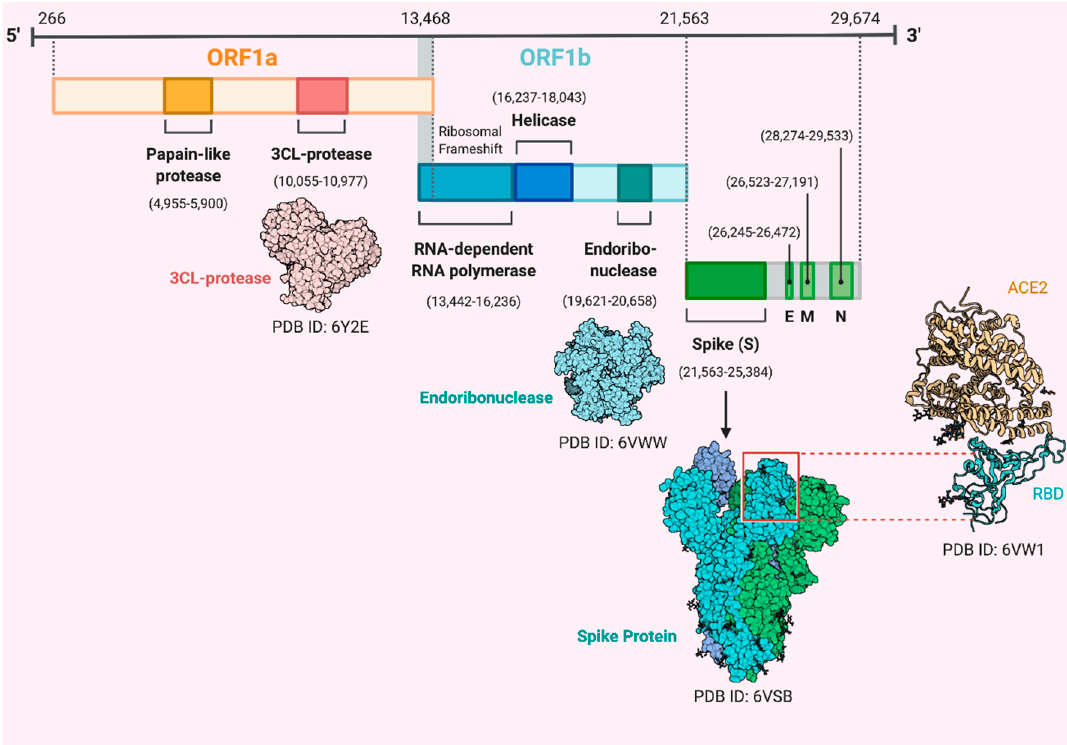
Figure 1. Coronavirus structure showing the organization of spike (S), membrane (M), and envelope (E) proteins. The viral RNA is associated with the nucleocapsid protein (N). ACE: angiotensin converting enzyme; RBD: receptor-binding domains; S1-NTD: N-terminal domain; S1-CTD: C- terminal domain; S1: amino termini; S2: carboxy termini.